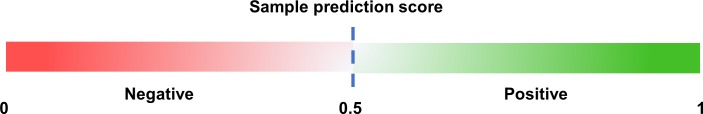
Evaluation criteria for predicted scores.